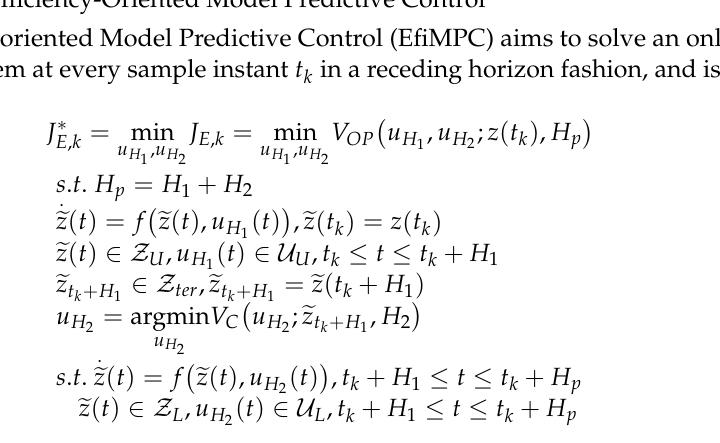
Figure 6. The nested structure of Efficiency-oriented Model Predictive Control.